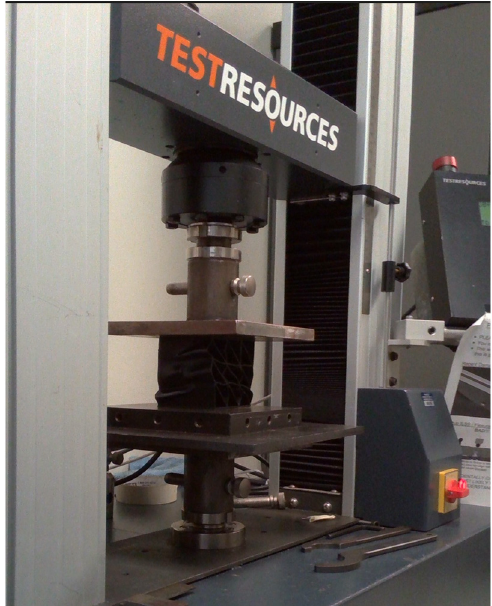
Figure 4. Test Resources Series 313 Universal Test Machine. All quasi-static compression trials were performed on this machine located at the Fibers and Composites Manufacturing Facility (FCMF) of the University of Tennessee (UT).